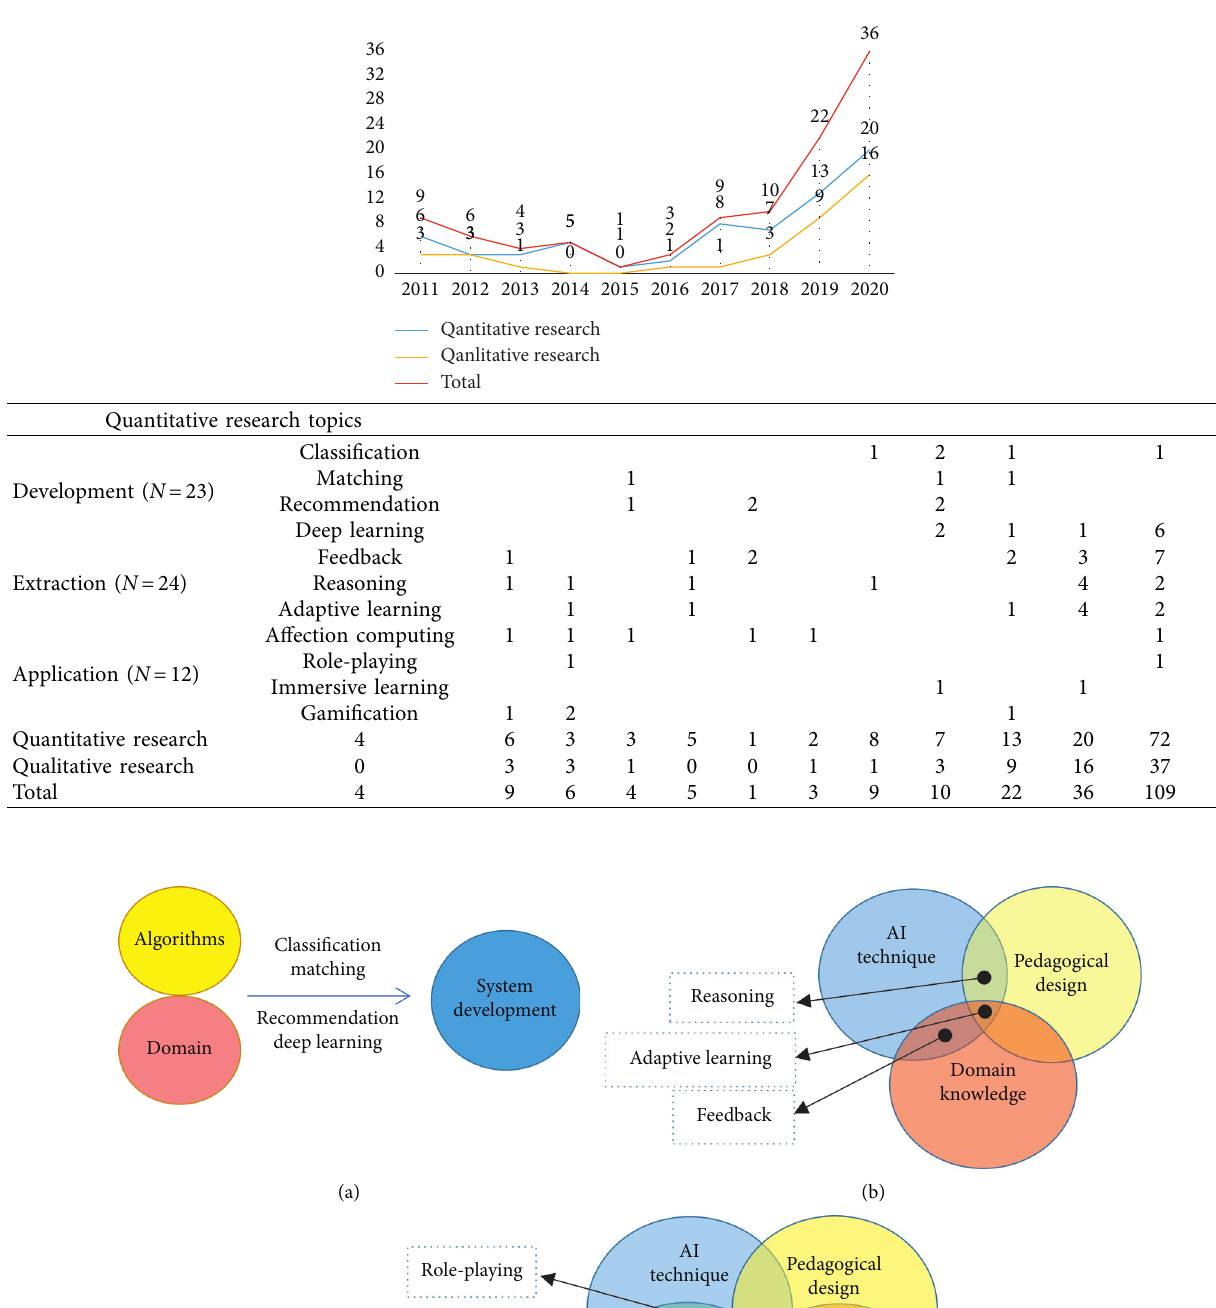
Table 2: The number of studies concerning AI in education from 2010 to 2020.